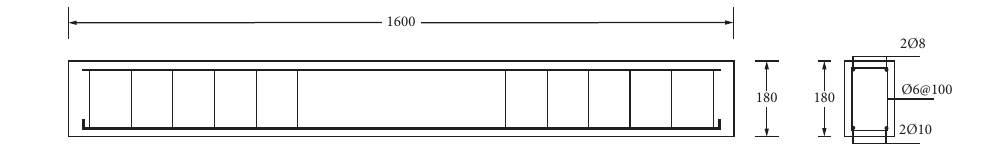
Figure 2: Size and reinforcement diagram of the test beam (unit: mm).